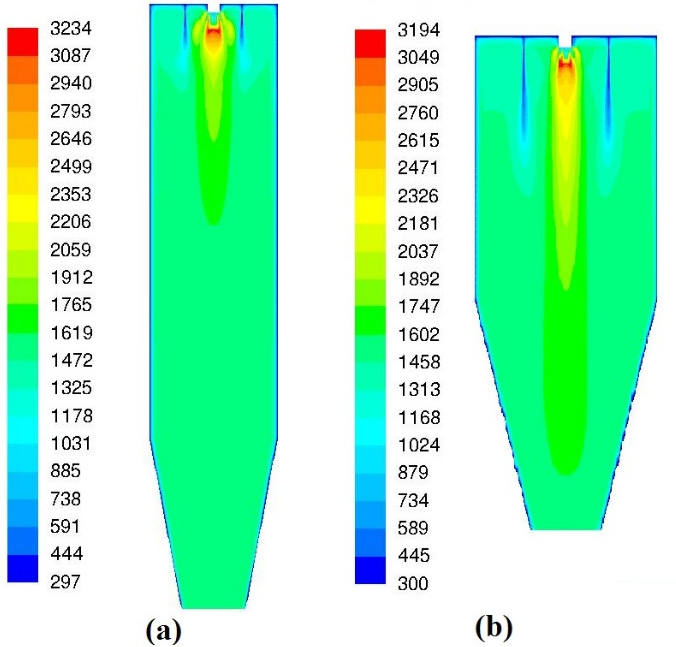
Figure 13. Temperature (in K) distribution in the plane passing through the centers of two powder feeding ports: ( a ) design No. 1 and ( b ) design No. 3 under operating conditions listed in Table 5.